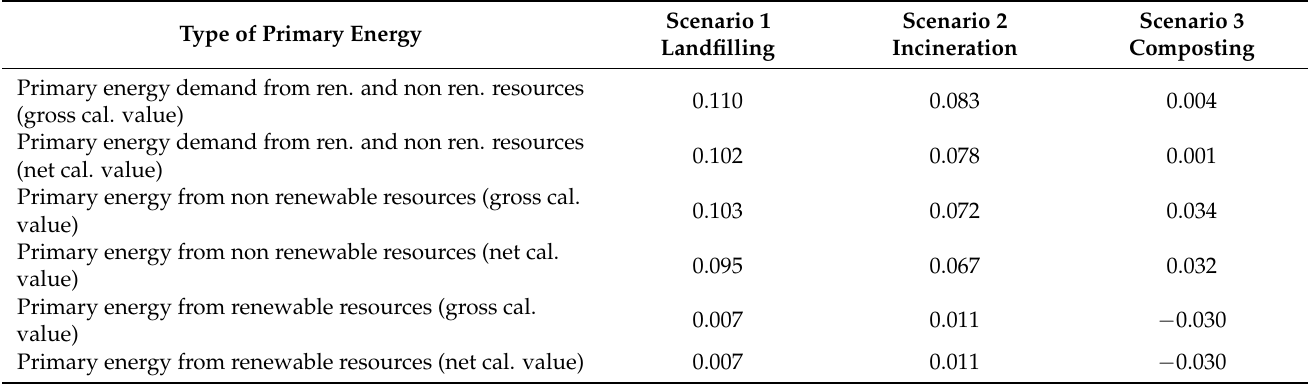
Table 4. Primary energy values for the end-of-life scenarios in MJ. (Functional unit: food waste of 0.05 kg).